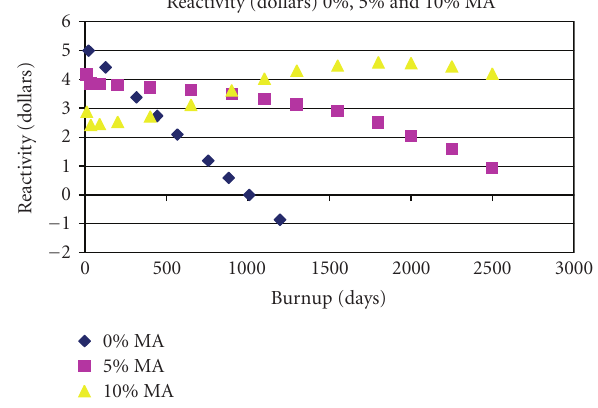
Figure 4: The reactivity for di ff erent MA loadings expressed in dollars. Note that a very long irradiation interval can be achieved with a very low reactivity swing.